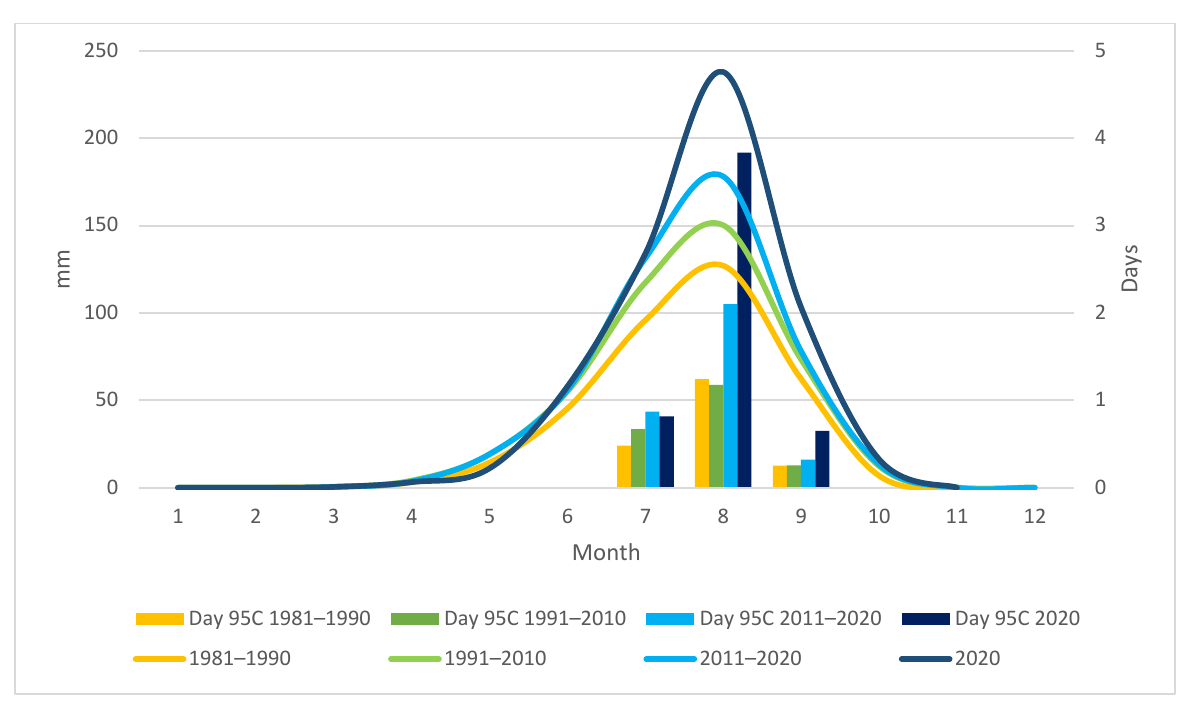
Figure A4. Rainfall distribution during the rainy season over MNRB (Chirps v2) and monthly number of days with precipitation >95th percentile. Table A5. Anomalies of red AMAX and extreme rainfall indexes for years with red AMAX anomaly <-1 st.dev (sorted by Red AMAX).